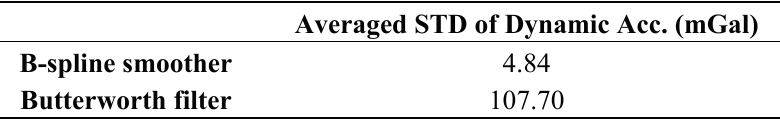
Figure 11. Distribution of ZUPT points (background map courtesy of Google Map). Table 3. Statistical results of different filters.